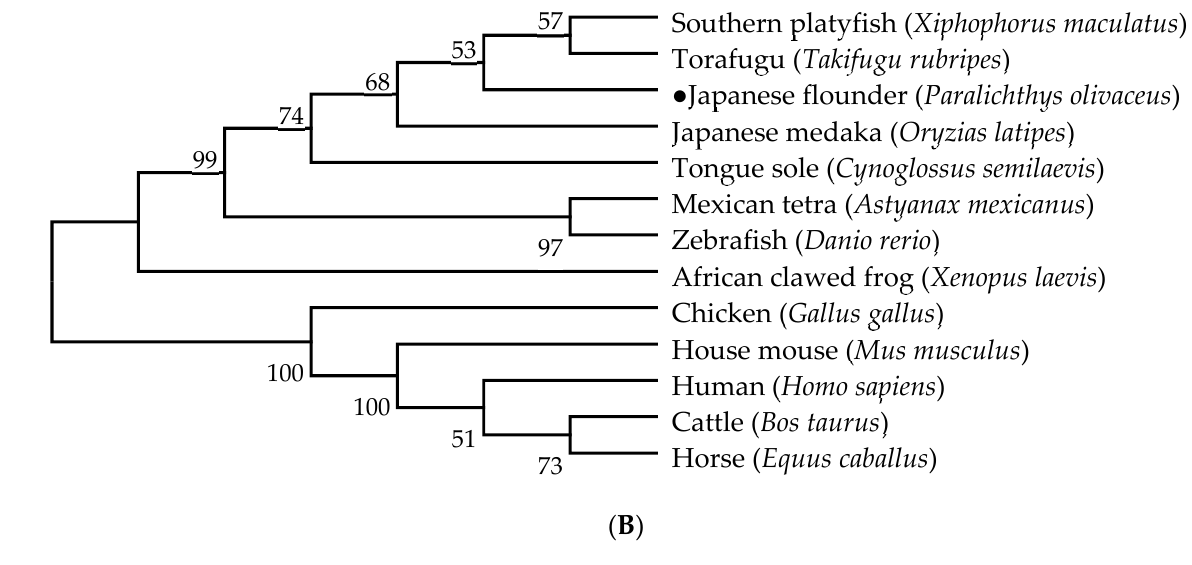
Figure 6. Phylogenetic trees of HIF-1 α ( A ) and LDH-A ( B ). The site of Japanese flounder is marked with a solid black dot ( ● ). The accession numbers of HIF-1 α protein are: Japanese flounder ( Paralich-